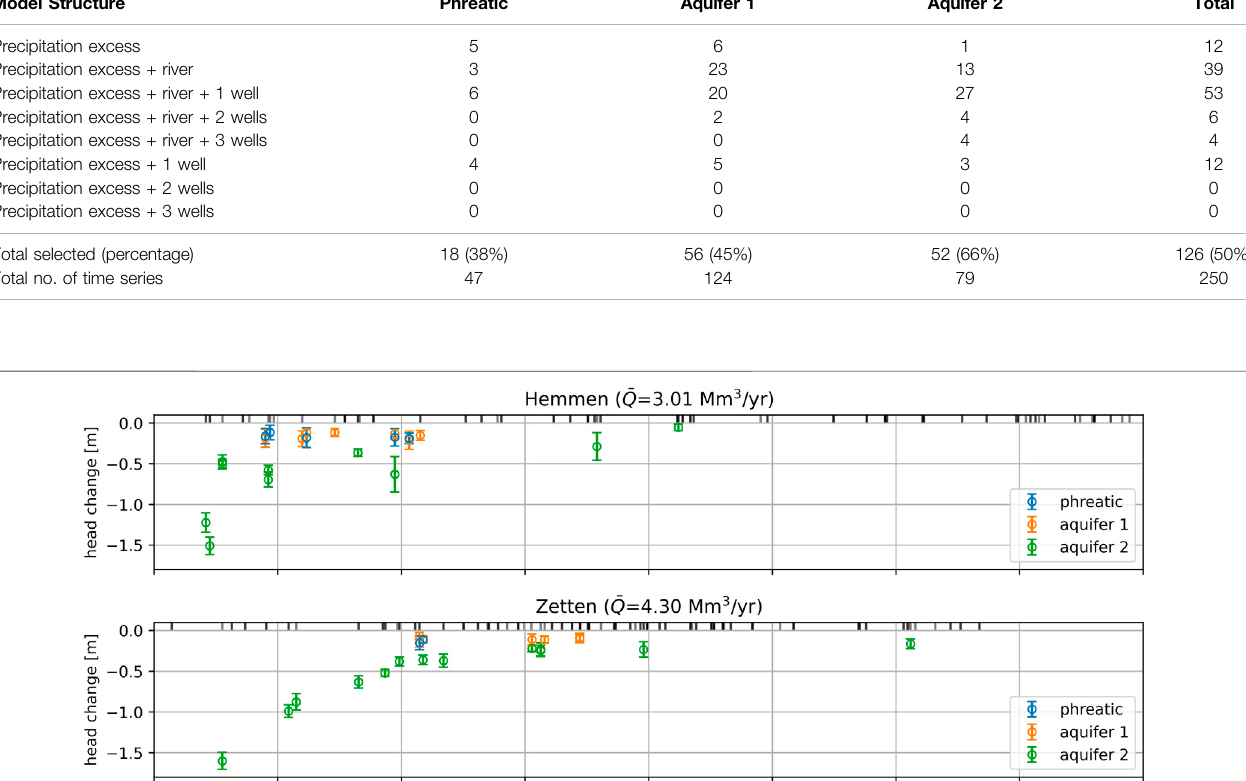
TABLE 3 | Summary of model structures for selected time series models, counted per aquifer. Model Structure